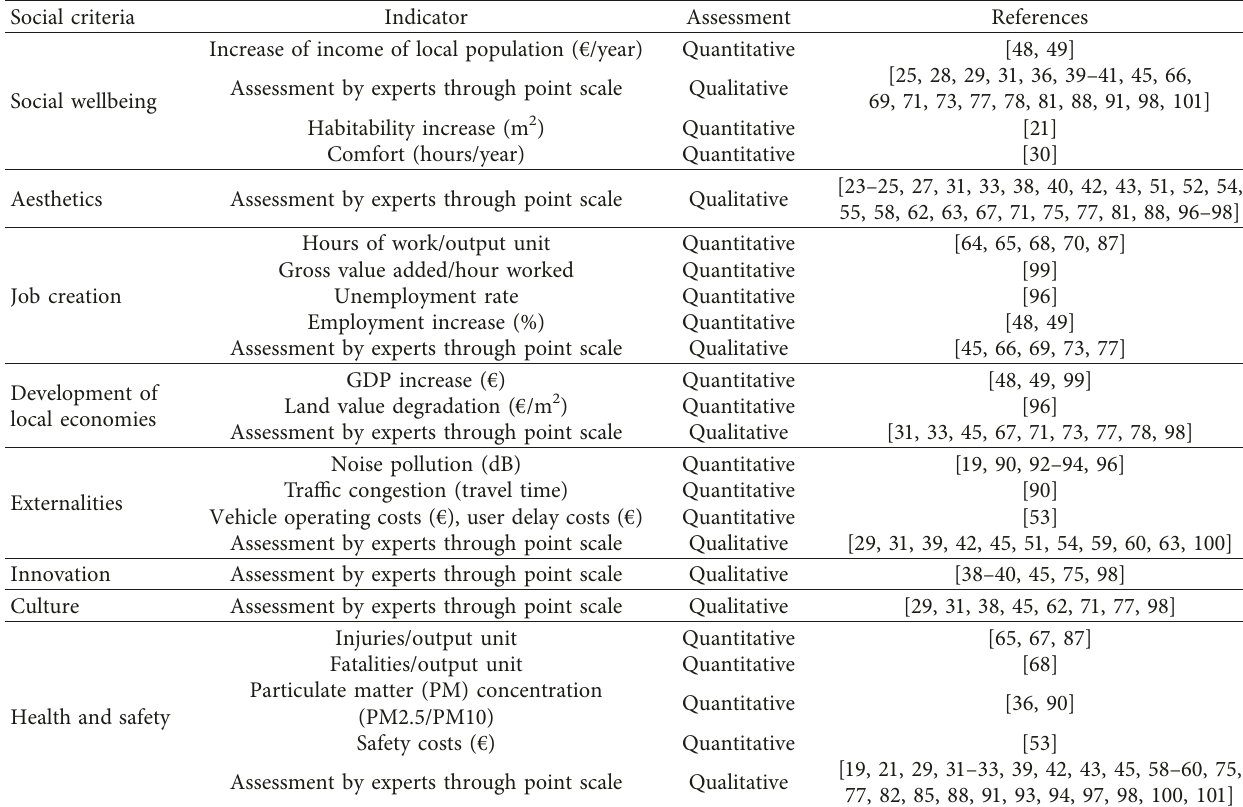
Table 3: Main social criteria and